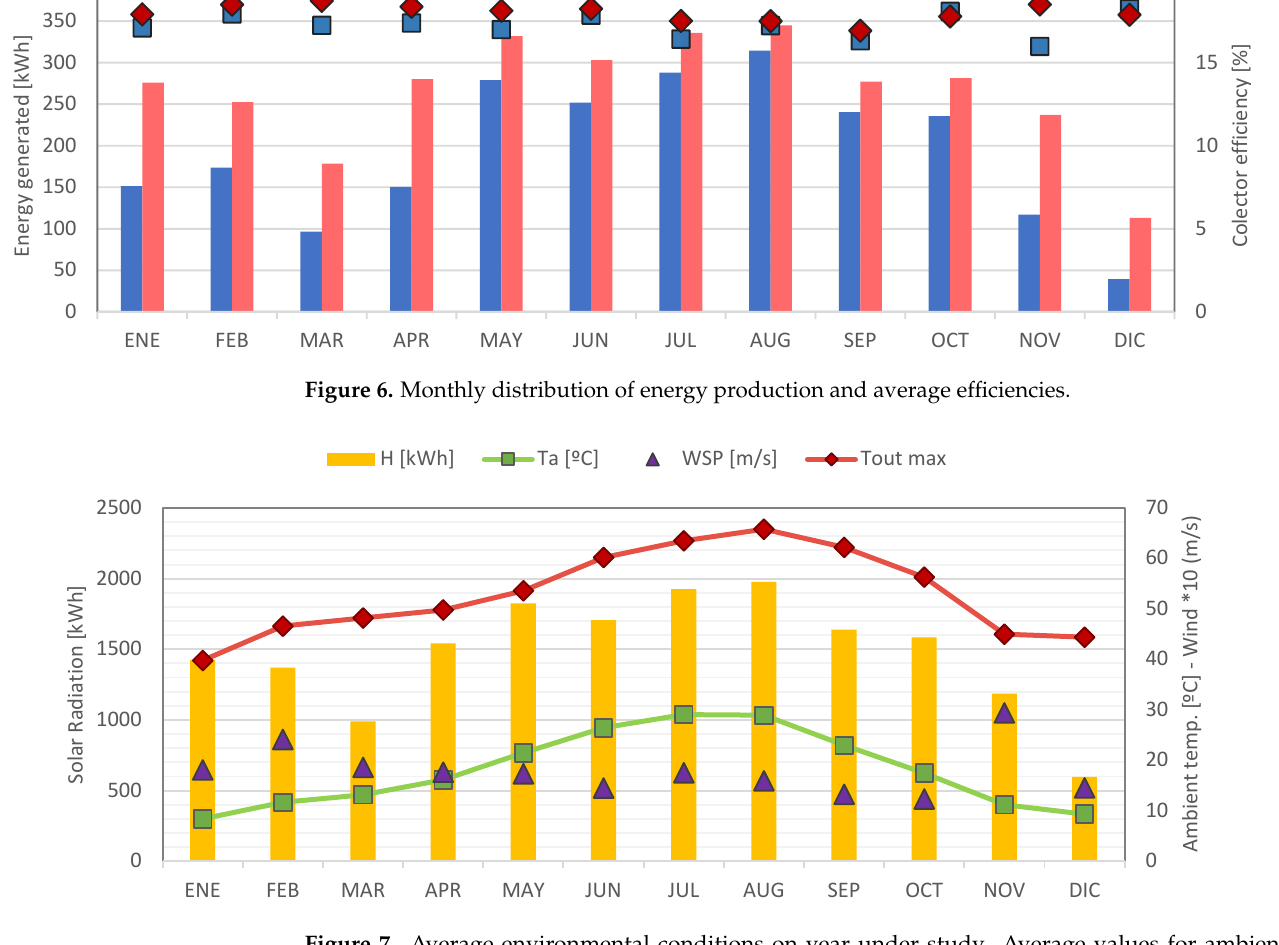
Figure 7. Average environmental conditions on year under study. Average values for ambient temperature and wind speed are calculated only during the day.